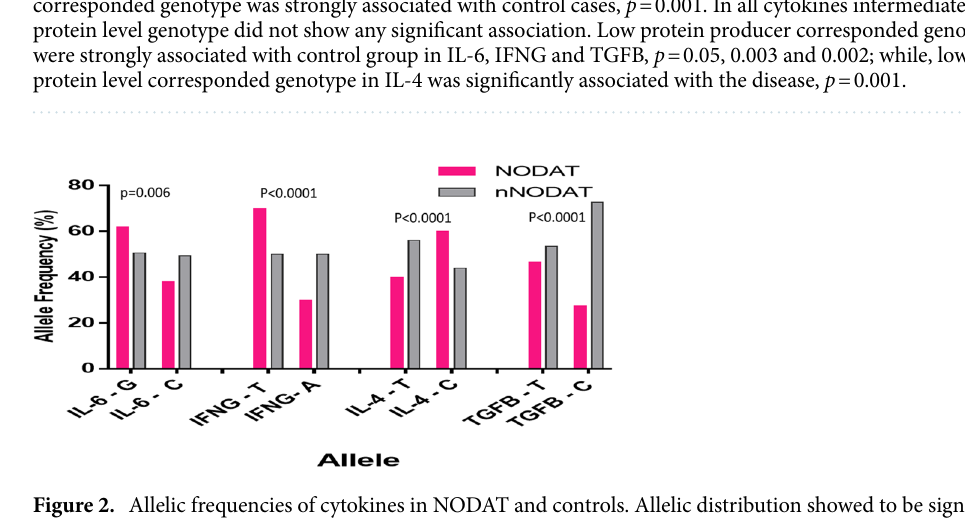
Figure 2. Allelic frequencies of cytokines in NODAT and controls. Allelic distribution showed to be significant in NODAT compared to control, IL-6 ( p = 0.006), IL-4 ( p ≤ 0.0001), IFNG ( p ≤ 0.0001) and TGFB ( p ≤